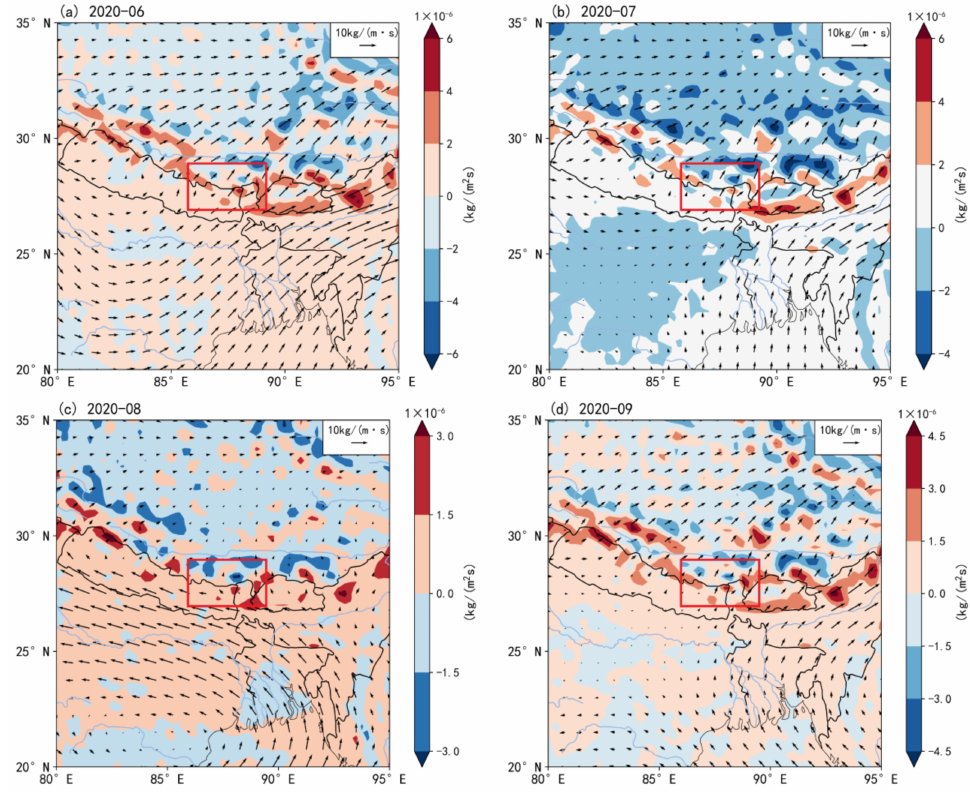
Figure 6. Water vapor flux (vector) and water vapor flux divergence (color) during monsoon period in